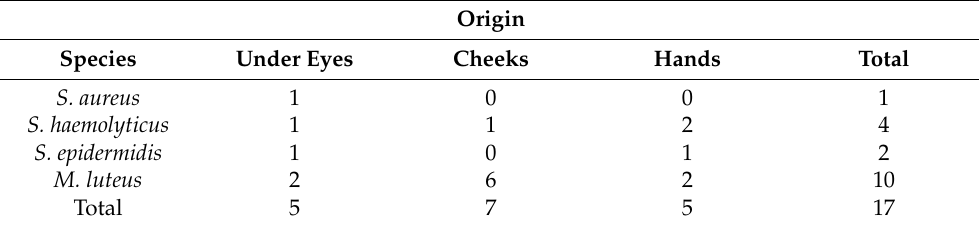
Table 3. Number of commensal bacterial strains, the growth of which was increased, as a result of the Hyal/O 3 foil application.